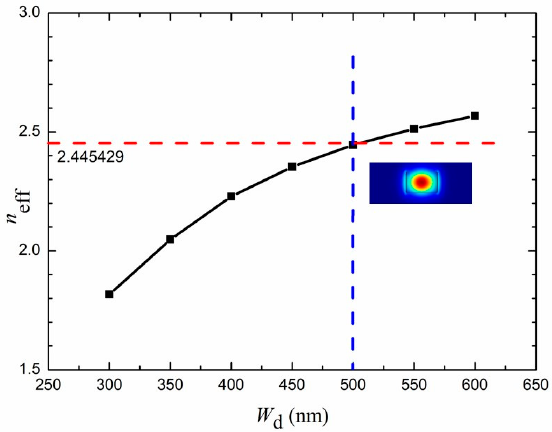
Figure 2. Effective refractive index n eff as a function of silicon straight waveguide W d .